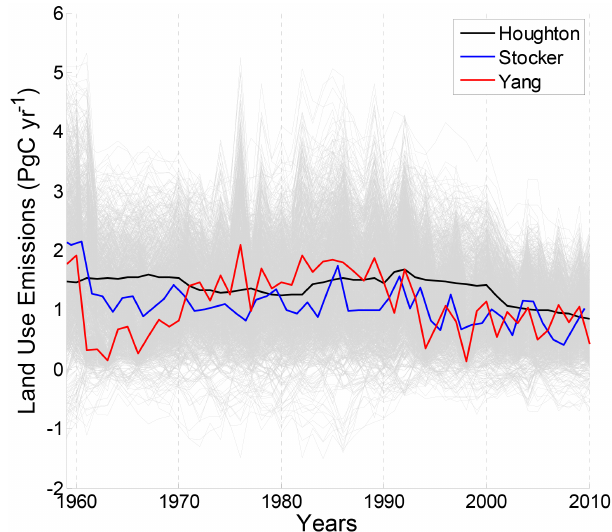
Figure 4. Comparison of land-use–land-change emission inven- tories from 1960 to 2010. The three inventories compared are the bookkeeping approach (Houghton et al., 2012; black), model- derived estimates including historical land use (Stocker et al., 2013: blue), and model-derived estimates, including historical land use and nitrogen cycling (Yang et al., 2010; red). Thin grey traces rep- resent the Monte Carlo simulations of uncertainty for the land use emission estimates ( N = 3 × 500 =